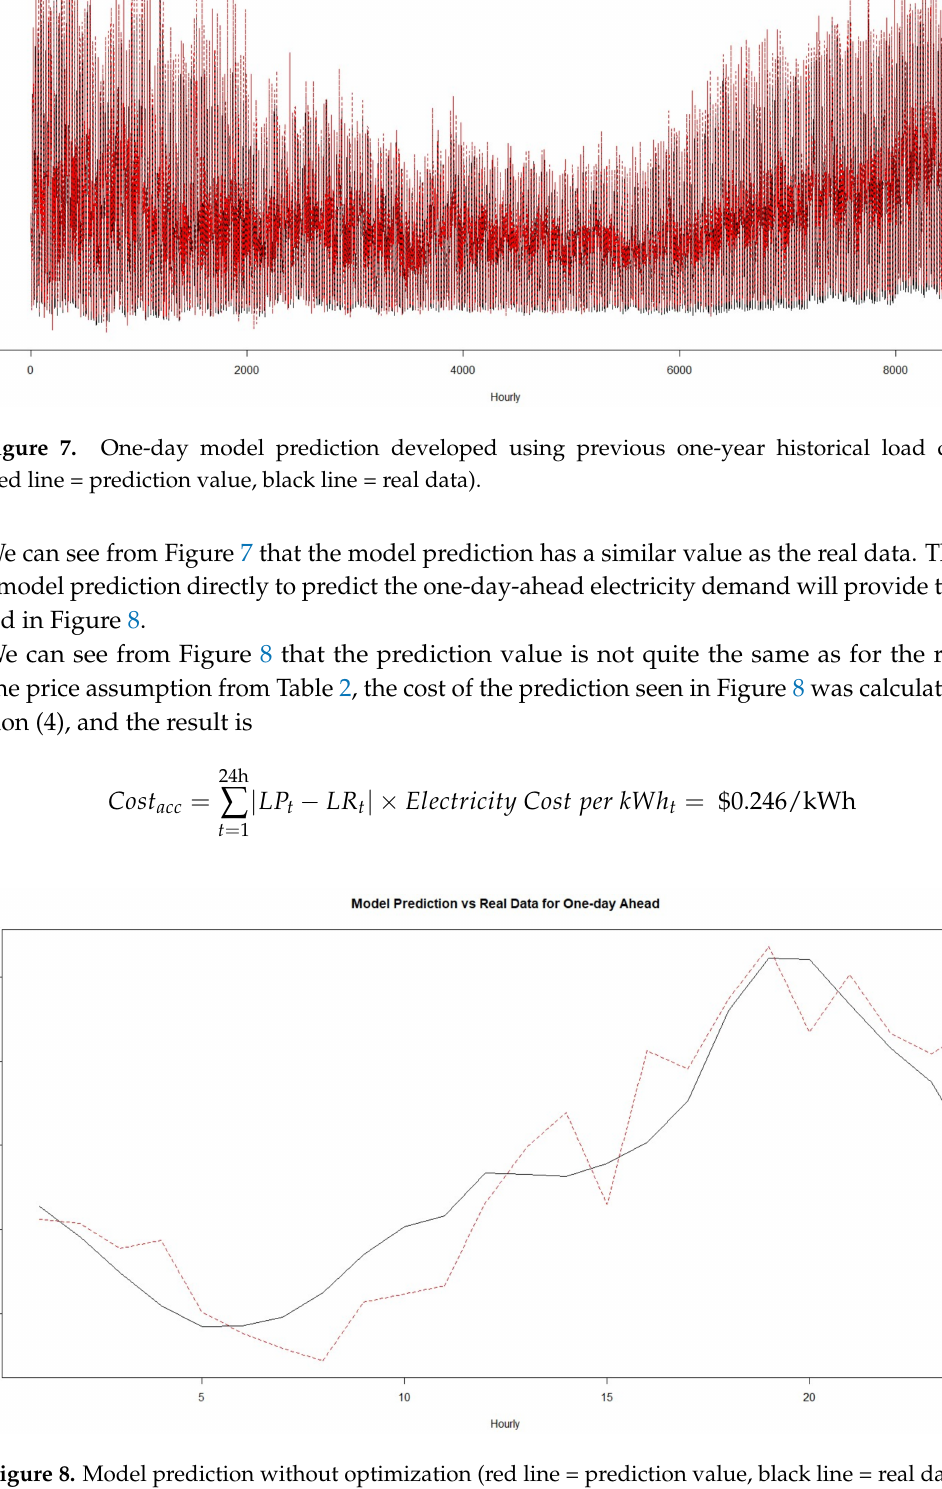
Figure 8. Model prediction without optimization (red line = prediction value, black line = real